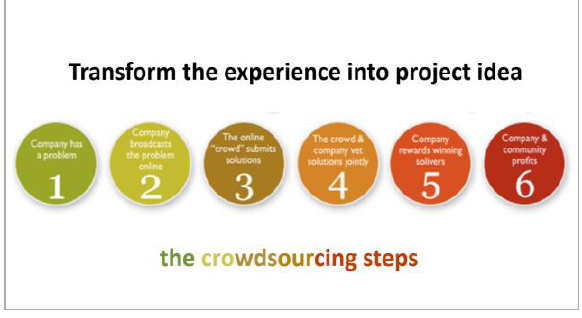
Figure 5. The crowdsourcing steps